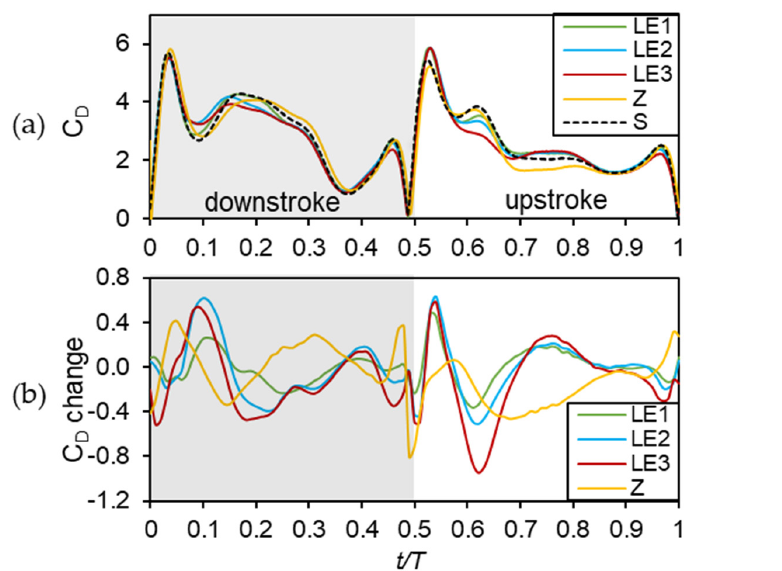
Figure 11. Comparison of drag coe ffi cient: ( a ) the time courses of drag coe ffi cients (C D ) and ( b ) the changes in the drag coe ffi cients (C D change) of the Z, LE1, LE2, and LE3 wings, compared to those of the S wing, at r = 0.75 R . Table 2. Changes in the average lift coe ffi cients (C L ), drag coe ffi cients (C D ), and gliding ratios (C L / C D